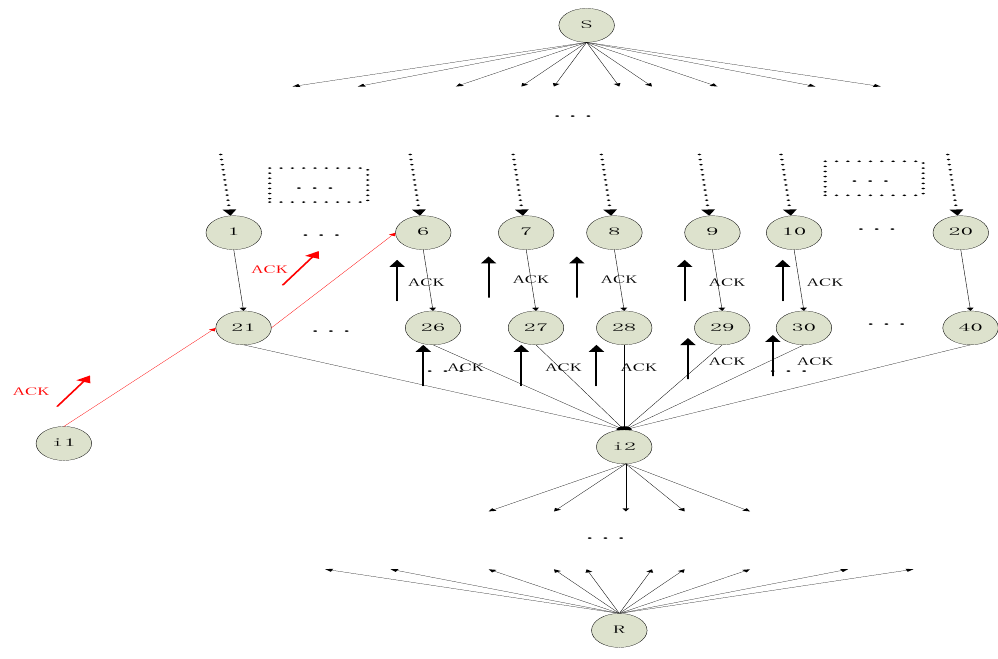
Figure 5. The building procedure of reputation-based trust about an intermediate node. The node i 1 is another node which is similar to i 2. The red ACKs are part of all the ACKs which are sent by the i 1.